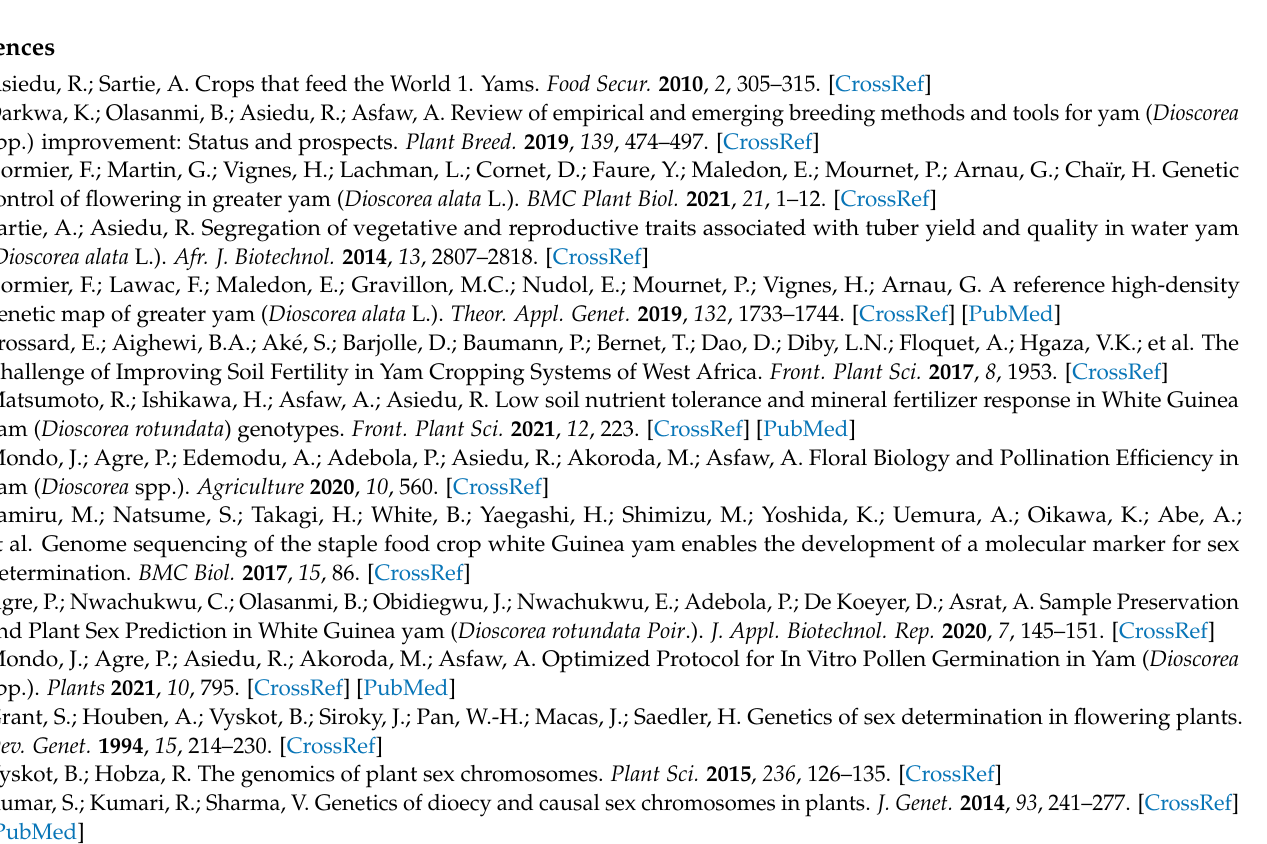
D. alata , Table S3: Candidate gene/protein families annotated in regions controlling target traits, Table S4: Weather and soil variables of the IITA yam breeding